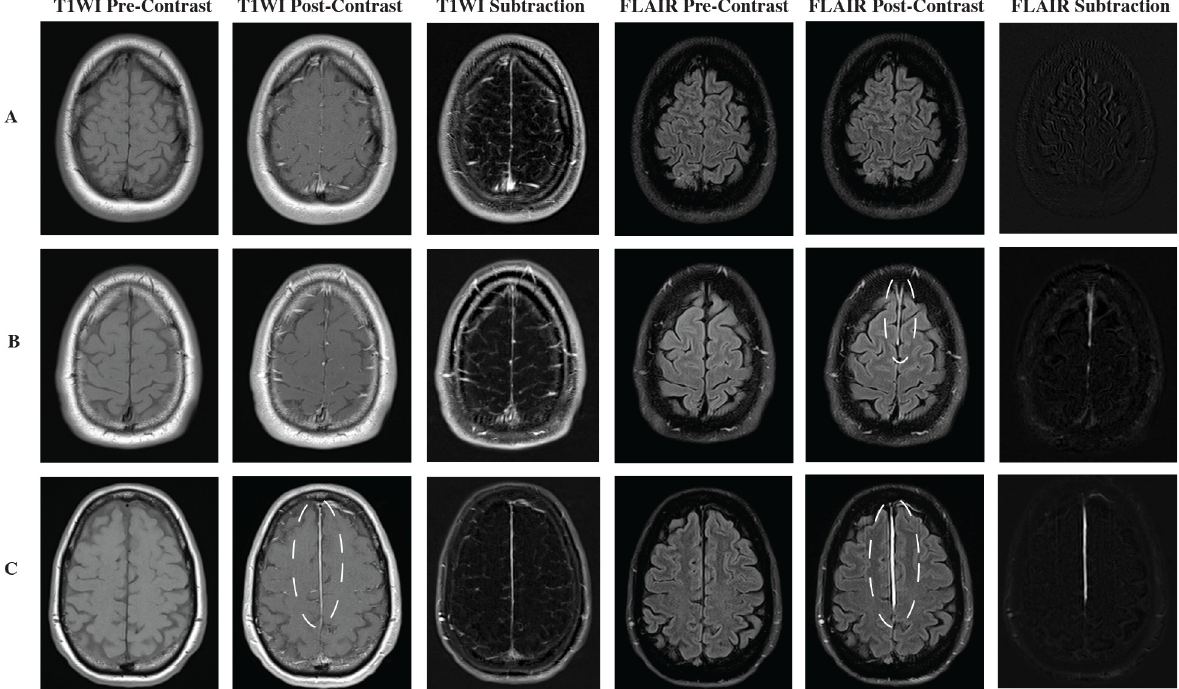
Fig 3. Examples of subjects studied in this cohort with possible scoring combinations by blinded readers. (A) Sets of T1WI and FLAIR pre and post-contrast of a subject scored as negative all around by all readers on both sets of sequences. (B) Sets of T1WI and FLAIR pre and post-contrast for a subject scored as positive for traumatic meningeal enhancement only on FLAIR sequence, as denoted by the dotted line. Traumatic meningeal enhancement is most conspicuous in the FLAIR post-contrast scan in both the falx cerebri and right convexity. (C) Pairs of T1WI and FLAIR pre and post-contrast scored as positive for traumatic meningeal enhancement on both sequences. Traumatic meningeal enhancement is denoted by the dotted line and is visualized in the falx cerebri alone on both post-contrast scans. The subtraction images visually represent the calculated differences between the pre-contrast and post-contrast T1 or FLAIR images, respectively. The T1 subtraction displays a vascular pattern not specific to meningeal enhancement, while the FLAIR subtraction primarily shows TME when it is present.